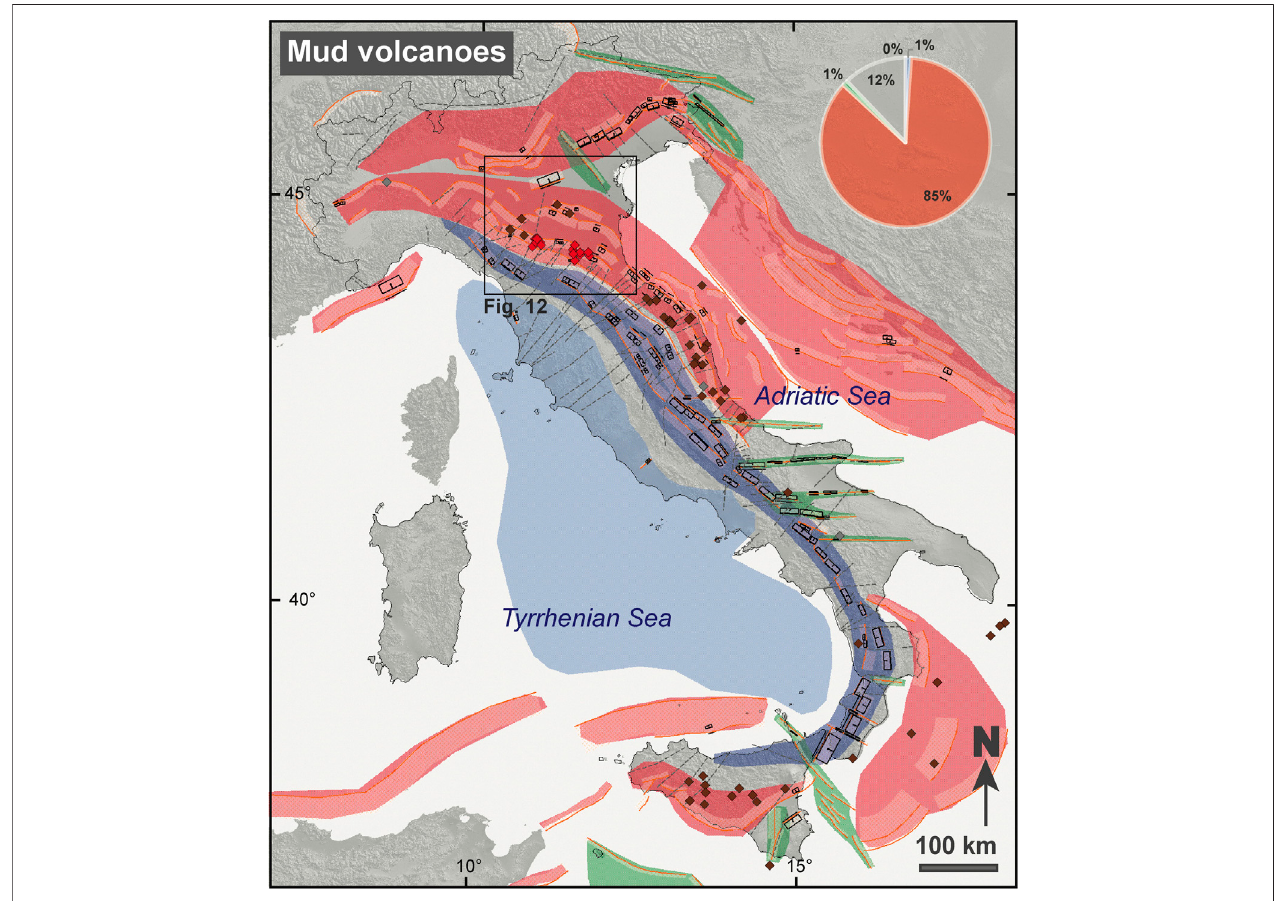
FIGURE 7 | Distribution of mud volcanoes (see Gas Seeps and Mud Volcanoes , CH 4 Emissions and Mud Volcanoes and CH 4 Emissions and Mud Volcanoes: The Signature of Contractional Domains Sections). Tectonic domains, seismogenic sources and transverse lineaments are shown as in Figure 2 . Removeddatapointsareshown ingrey.Selecteddatapointsareshowninredifthey arediscussedinthetext, otherwise indarkbrown.Theareashown witharectangle is discussed in CH 4 Emissions and Mud Volcanoes: The Signature of Contractional Domains Section. The pie chart shows the distribution of mud volcanoes in different active tectonic domains (see Table 1 ). Notice that as many as 85% of these peculiar phenomena fall in areas of active contraction.